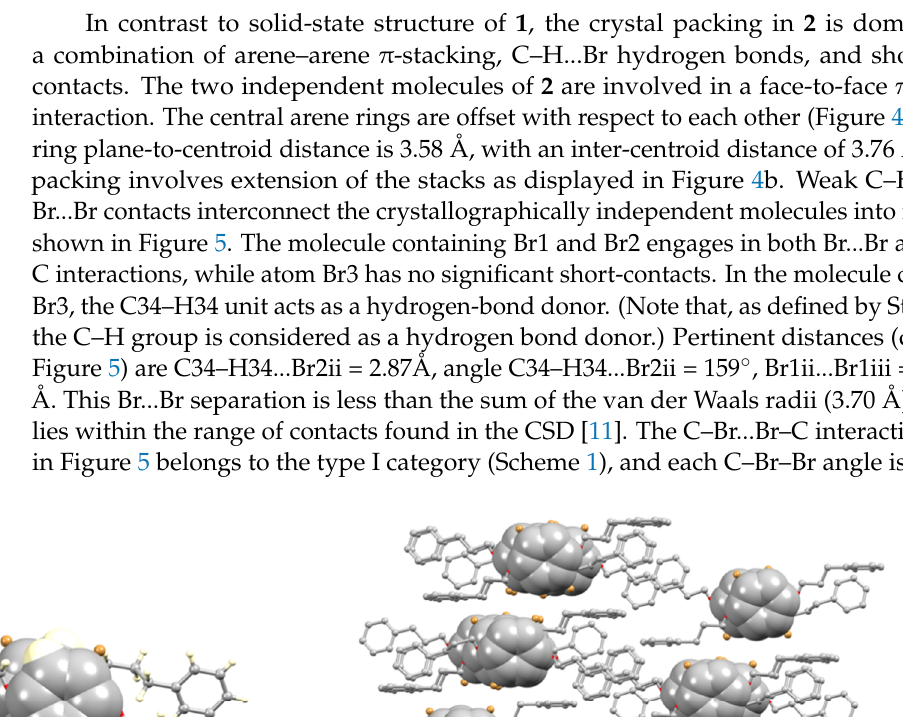
Figure 3. Packing of molecules of compound 1 (polymorph I) ( a ) Semi-localized interactions be- tween each Br and two arene C atoms of adjacent molecules. ( b ) View down the c -axis illustrating orthogonal sets of Br...arene interactions; H atoms are omitted for clarity.